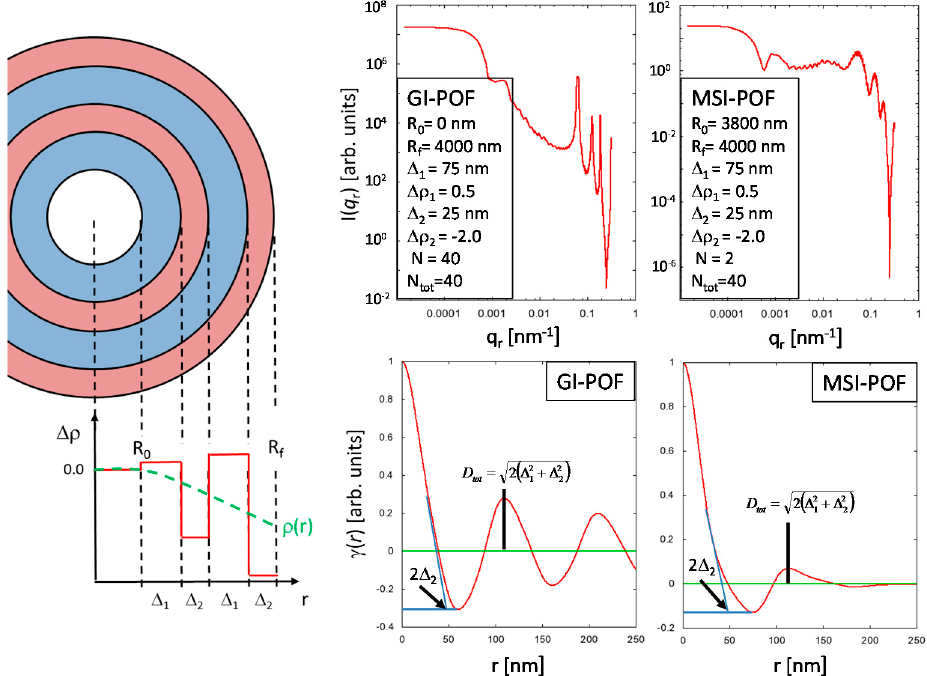
Figure 7. ( Left ) simple structure model for the description of radially decaying periodical density variations over the fiber cross-section. ( Top right ) equatorial SAXS intensity patterns of a model GI-POF and a two-step MSI-POF calculated with the structure model sketched on the left. The respective model parameters are displayed in the insets. For better visibility, high frequency oscillations in the SAXS curves were suppressed by a seven-point moving average. ( Bottom right ) equatorial distance-distribution functions for GI- and MSI-POF. The information content is essentially the same. In both cases, the smaller dimension ∆ 2 and the parameter D tot can be extracted from the functions.